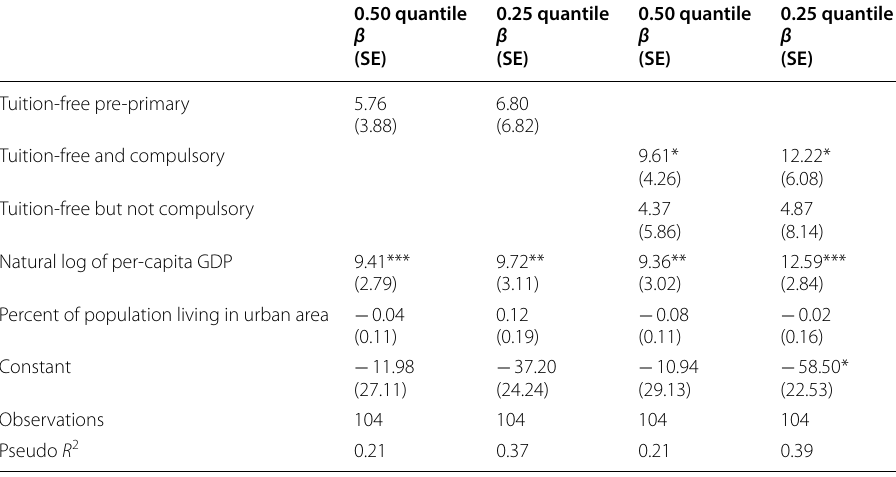
Table 2 Quantile regression models of the relationship between free and compulsory